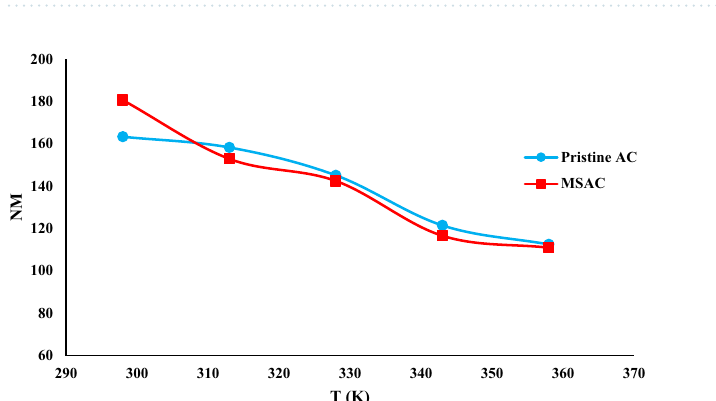
Figure 9. Schematic diagram for the change of phenol orientation onto MSAC and pristine activated carbon due to thermal agitation.